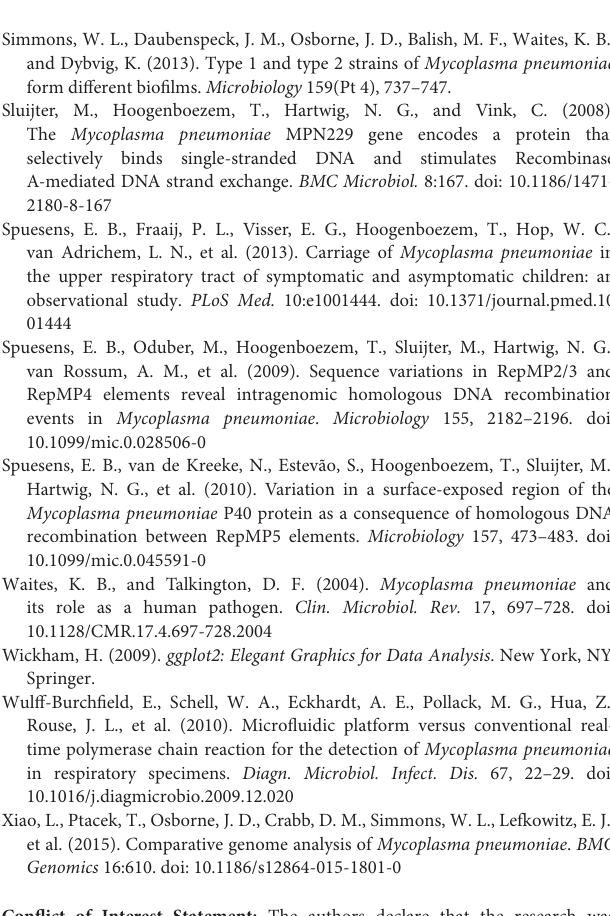
Supplementary Figure 1 | The results of the optimization on the assembly